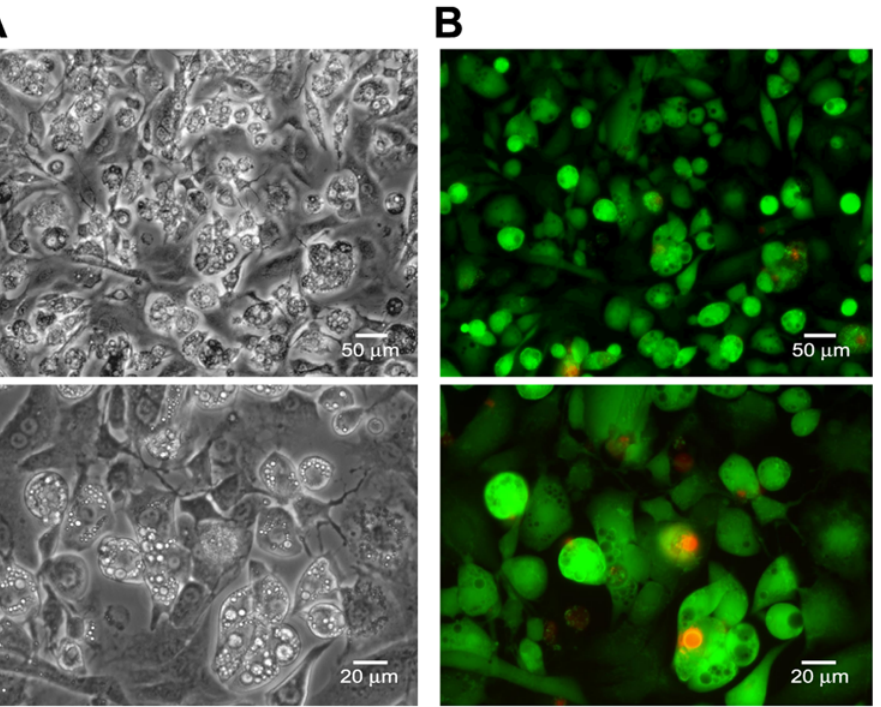
Figure 4. 3T3-L1 adipocytes maintain viability with lipid-based siRNA transfection. Cell viability was determined using Calcein-AM (green, viable cells) and propidium iodide (red, non-viable cells) staining in a ‘‘live-dead’’ assay. The assay was carried out at 48 hours post-transfection using non-targeting siRNA (Dharmacon siRNA pool # 2 containing luciferase siRNA). (A) Brightfield images taken with a 20X (upper panel) and 40X objective (lower panel). (B) Fluorescent images taken with a 20X (upper panel) and 40X objective (lower panel) showing minimal PI staining. The experiment was carried out twice independently.